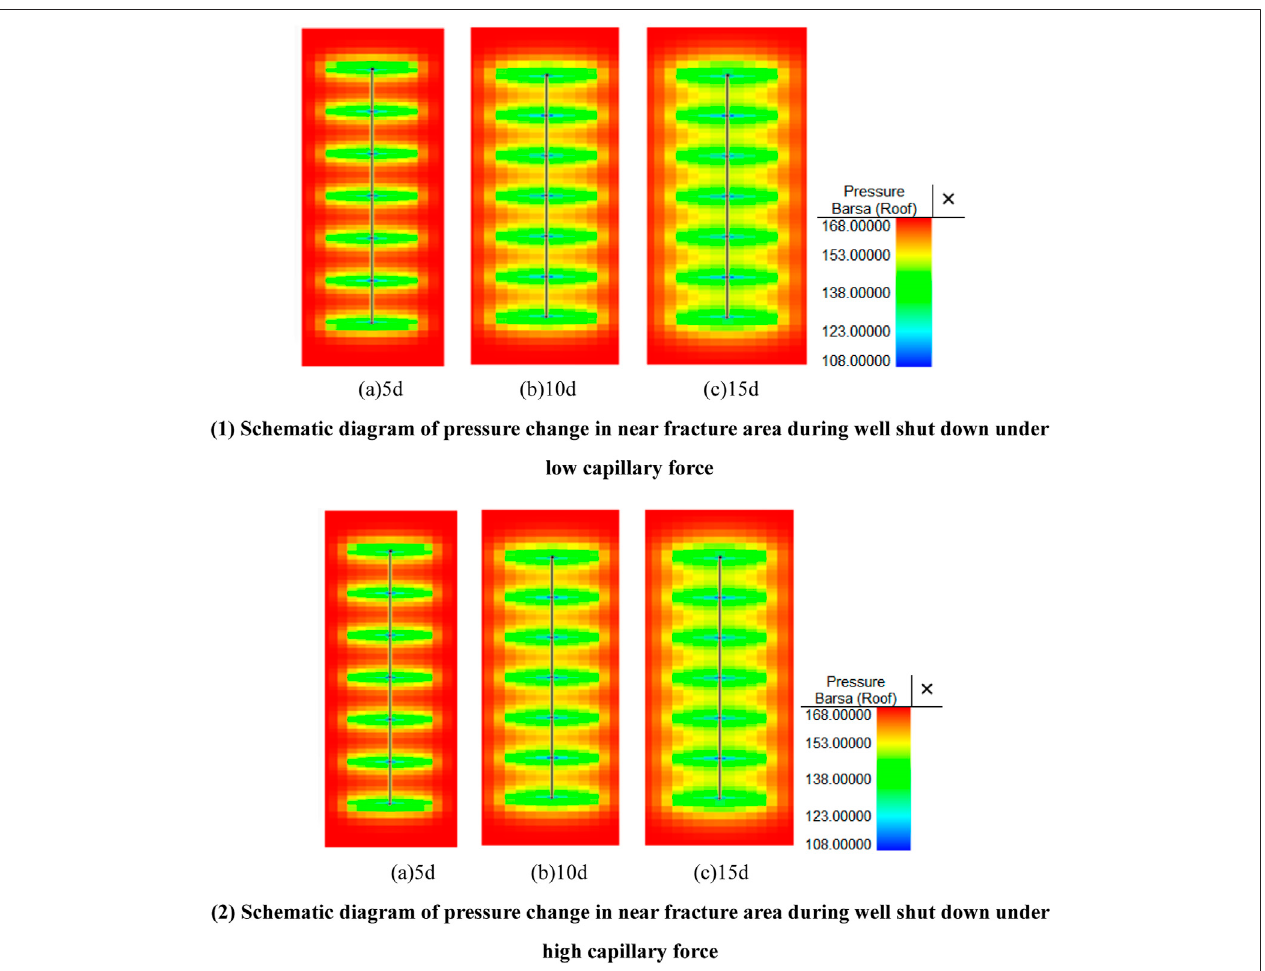
FIGURE 9 | Schematic diagram of pressure change in near fracture area during well shut down under different capillary force. (A) Schematic diagram of pressure change in near fracture area during well shut down under low capillary force (i) 5d, (ii) 10d, (iii) 15d. (B) Schematic diagram of pressure change in near fracture area during well shut down under high capillary force (i) 5d, (ii) 10d, (iii) 15d.